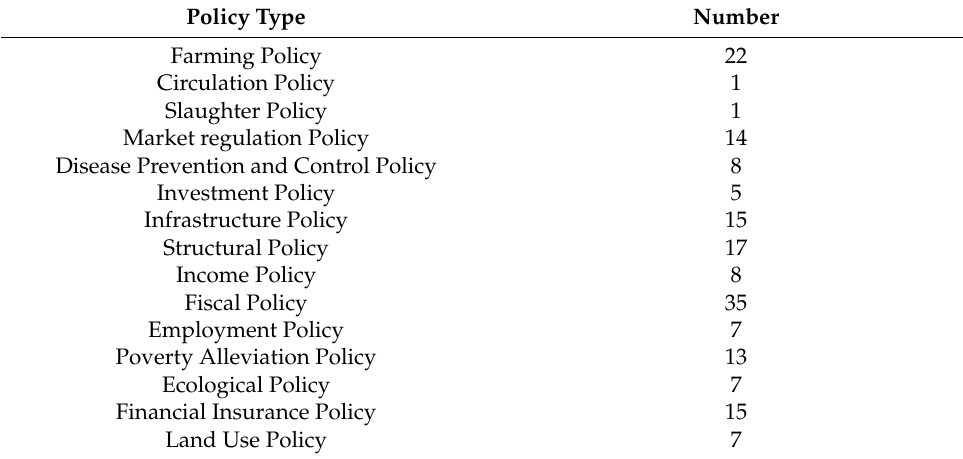
Figure 1. Policy attribute statistics chart. Table 1. Policy Type and